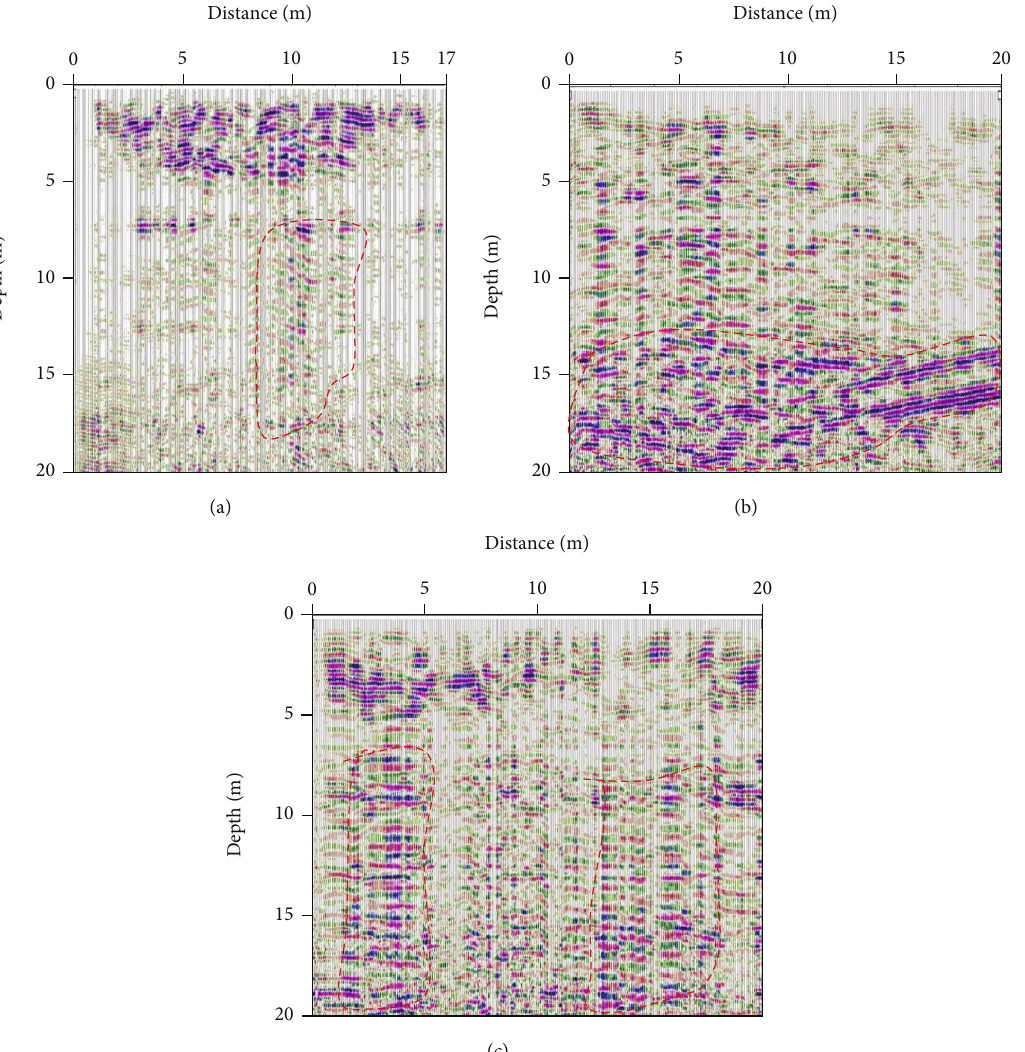
Figure 5: GPR pro fi les of ground surface detection: (a) line 1; (b) line 2; (c) line